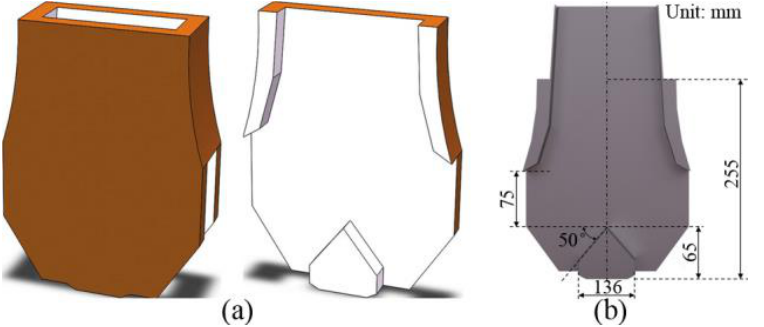
Figure 3. Schematic diagram of submerged entry nozzle of the CSP mold: ( a ) the geometric model of the SEN and ( b ) the dimensions of the SEN.